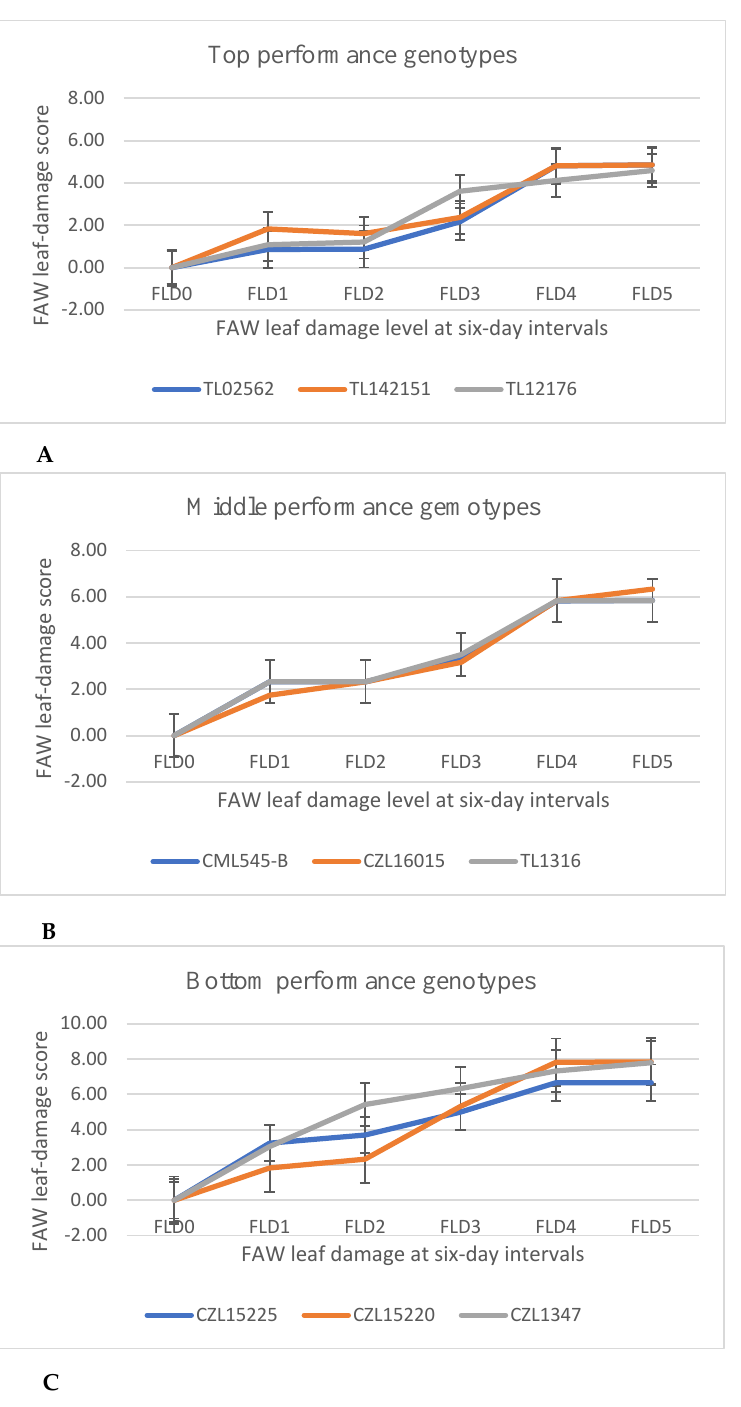
Figure 2. Pattern of damage progression for ( A ) top-performing, ( B ) middle-performing and ( C ) bottom-performing maize genotypes evaluated under artificial FAW infestation.